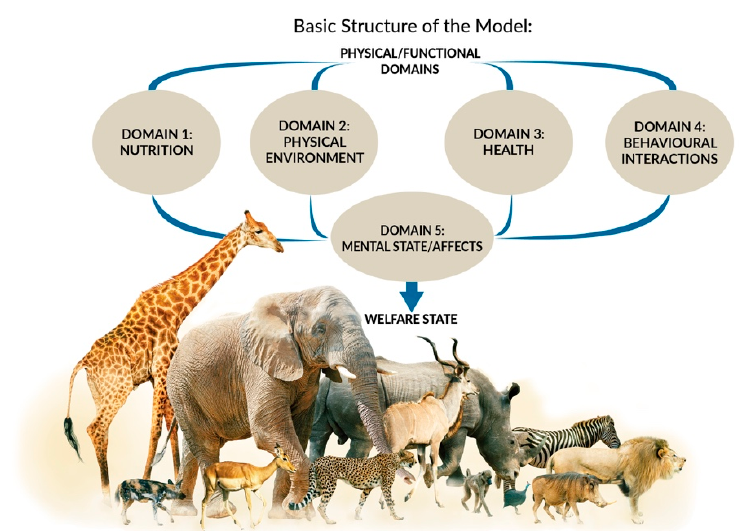
Figure 1. The 2020 Five Domains Model adapted by Cristina Wilkins from (Mellor et al. [17] ).